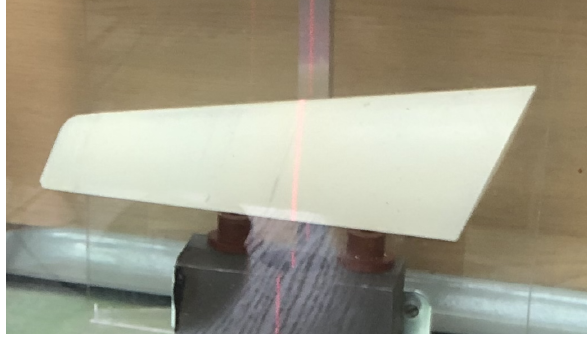
Figure 5. Reference 3D model of the wing for evaluation